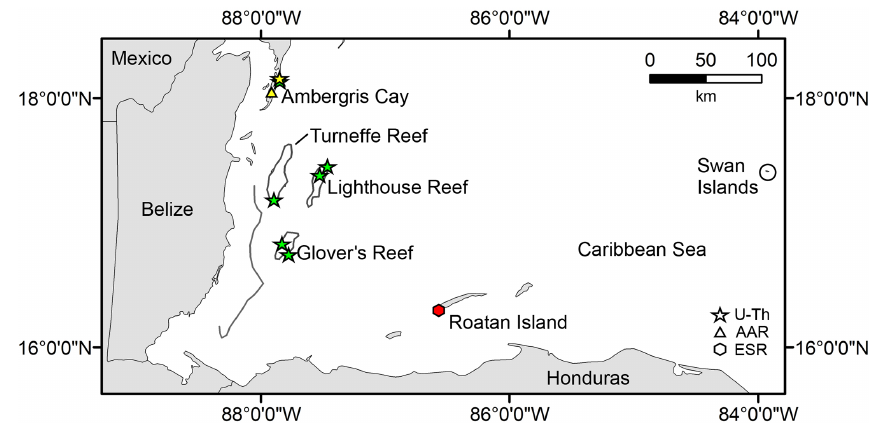
Figure 11. Map of the Belize and Honduras coastline showing the locations of U–Th (stars), amino acid racemization (shown as triangles), and electron spin resonance (shown as hexagons) ages discussed in the text. Ages in green denote the work of Gischler et al. (2000). Ages shown in yellow denote the work of Mazzullo (2006), and ages shown in red denote the work of Cox et al. (2008).